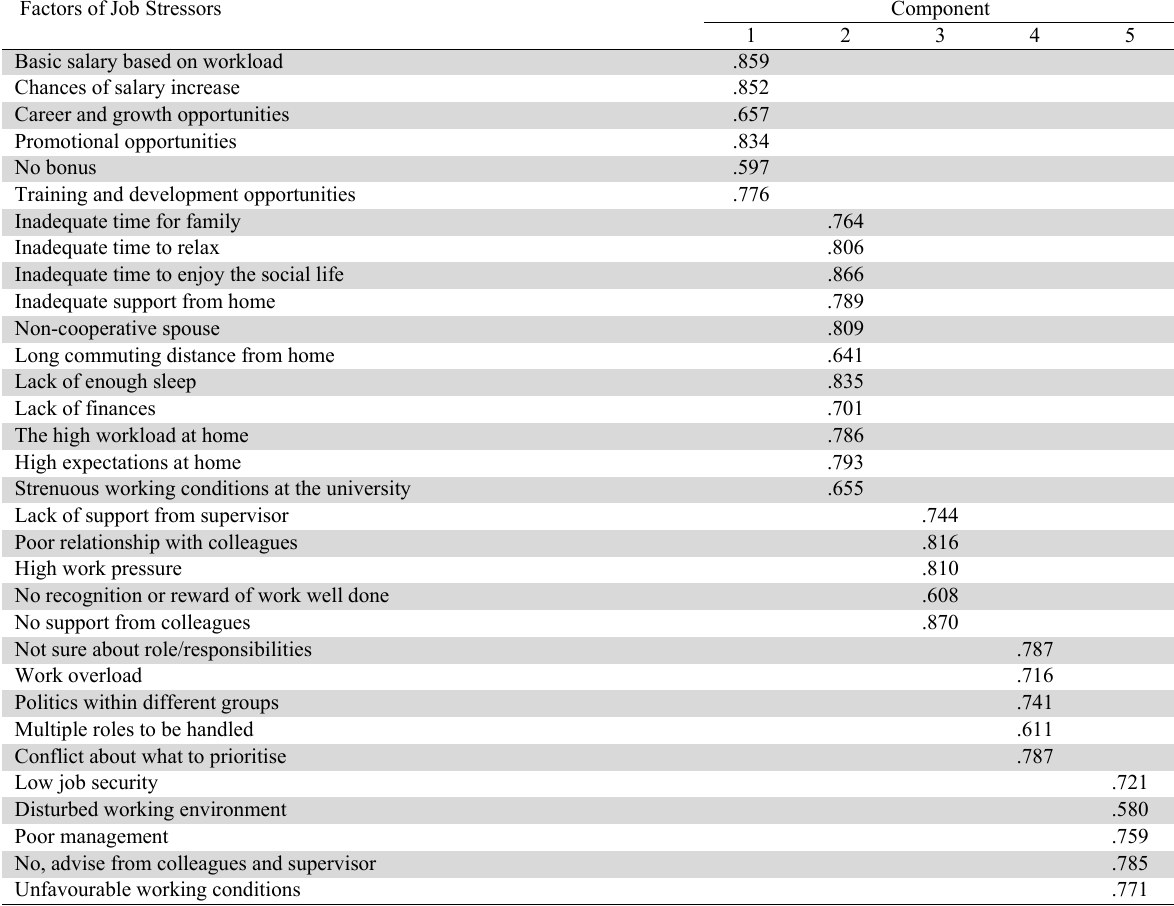
Rotated Component Matrix of Factor Analysis Factors of Job Stressors